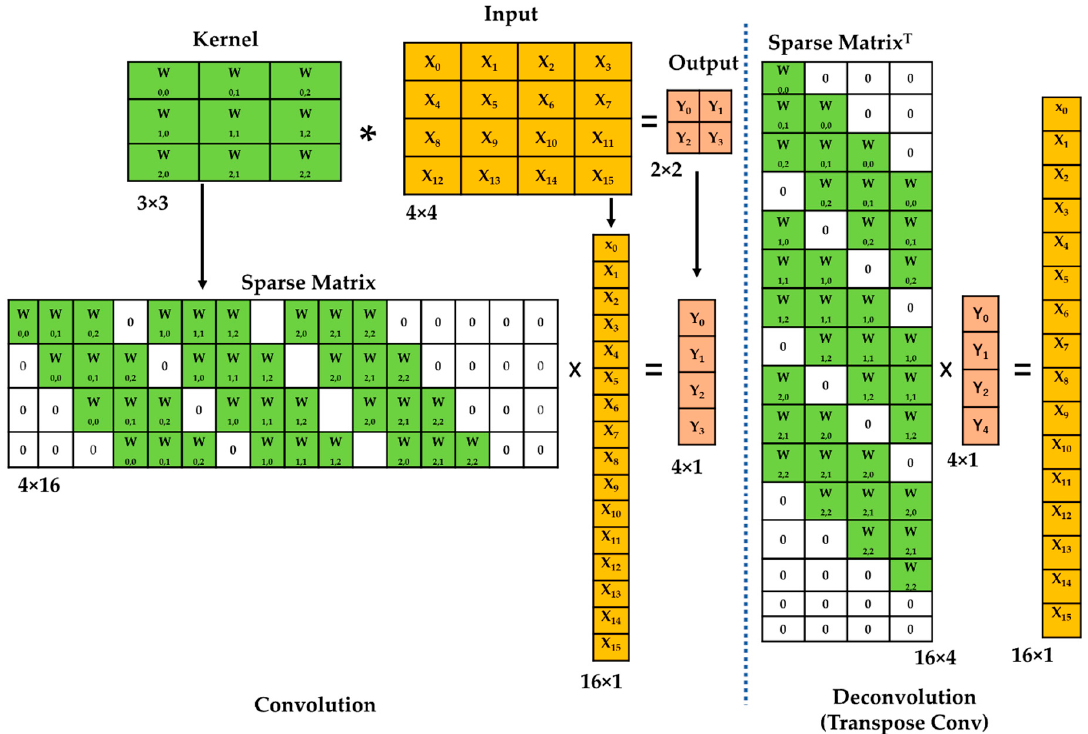
Figure 5. An example of the deconvolution process using transpose convolution. In the figure, * —Convolution; × —Matrix Multiplication.